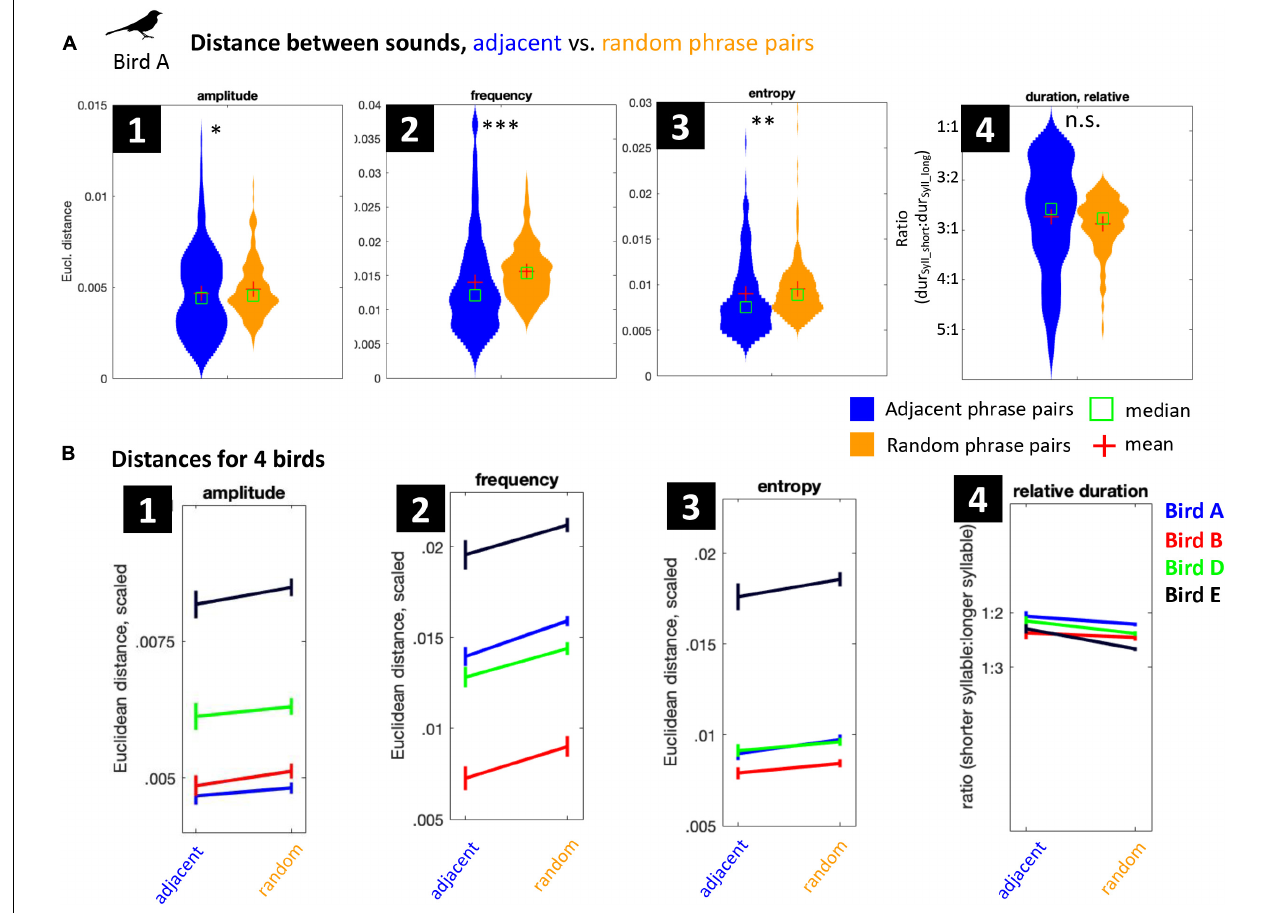
FIGURE 10 | Acoustic syllable similarity between adjacent-phrase pairs vs. random-phrase pairs. (A) Four metrics for acoustic distance between syllables of adjacent (blue) vs. random distant (orange) phrases, for bird A. Sampling methods are illustrated in Figure 2 . Mean Euclidean distances for (1) syllable amplitude (reflecting internal syllable dynamics), (2) frequency (reflecting syllable pitch), and (3) Wiener entropy (reflecting syllable timbre. (4) Syllable duration ratio (shorter syllable:longer syllable), reflecting whether the syllables are of similar or different length. Bird A’s amplitude, entropy, and frequency are significantly more similar between adjacent than between random phrases (Bonferroni-corrected for multiple comparisons). Syllable durations are not significantly different. (B) Same comparisons for four birds (including bird A, in blue). Error bars show